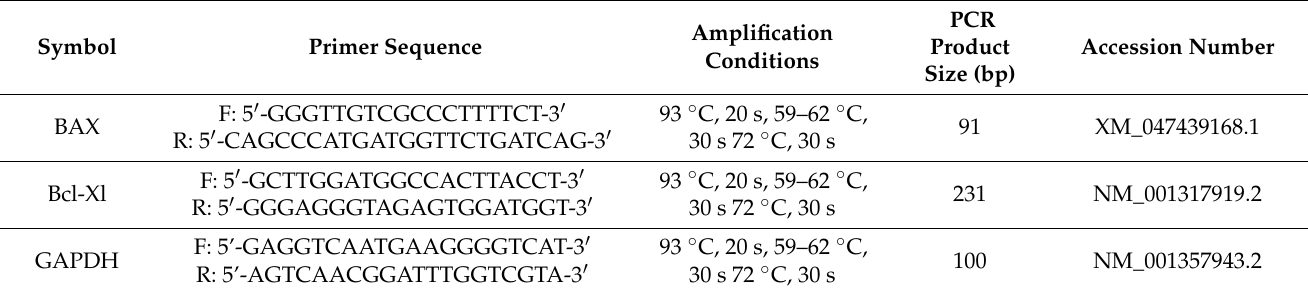
Table 1. The primers and conditions for